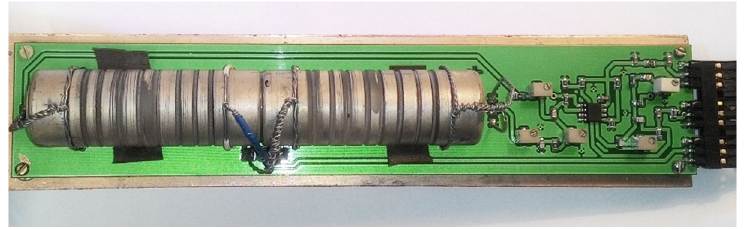
Figure 10. The RRS SE on CPAW.